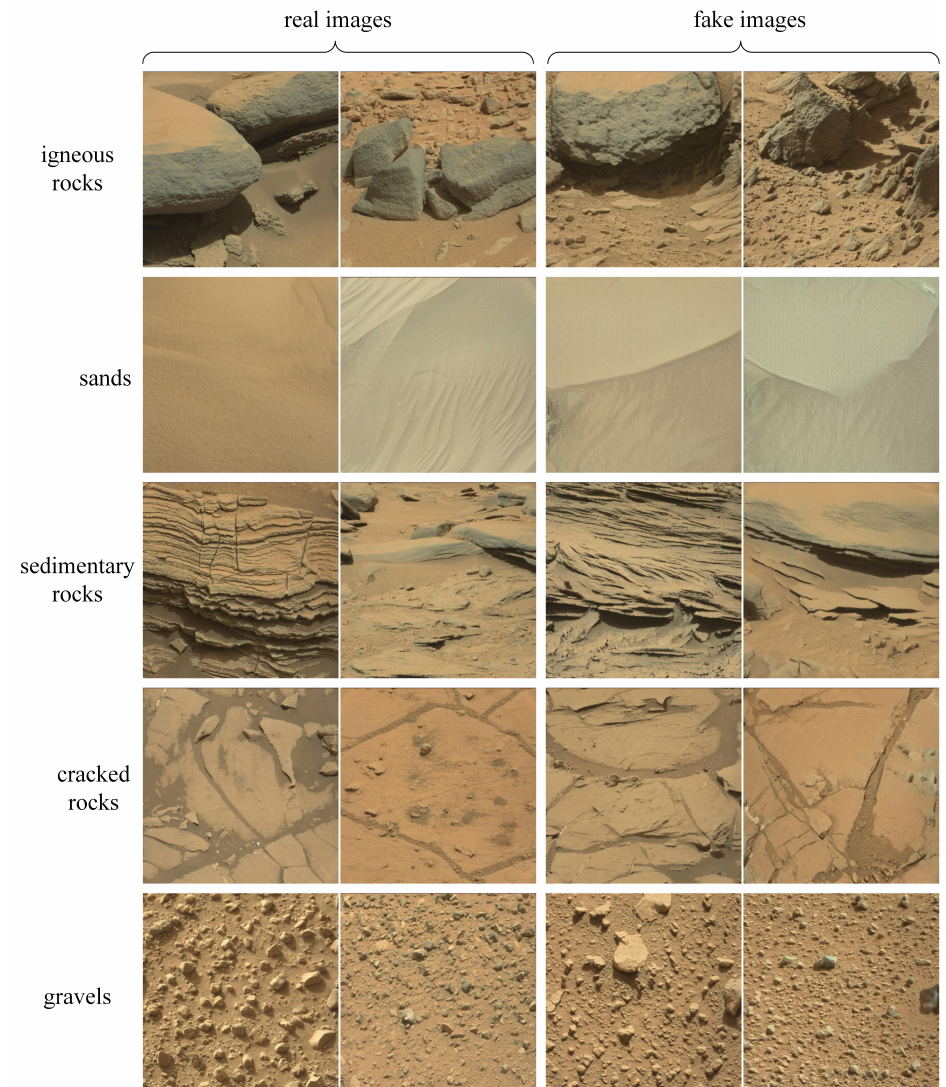
Figure 8. The comparison between the real images and the generated Mars images. Two real images and two generated Mars images were extracted from each subset for comparison and visualization, and further showing the effectiveness of the image generation